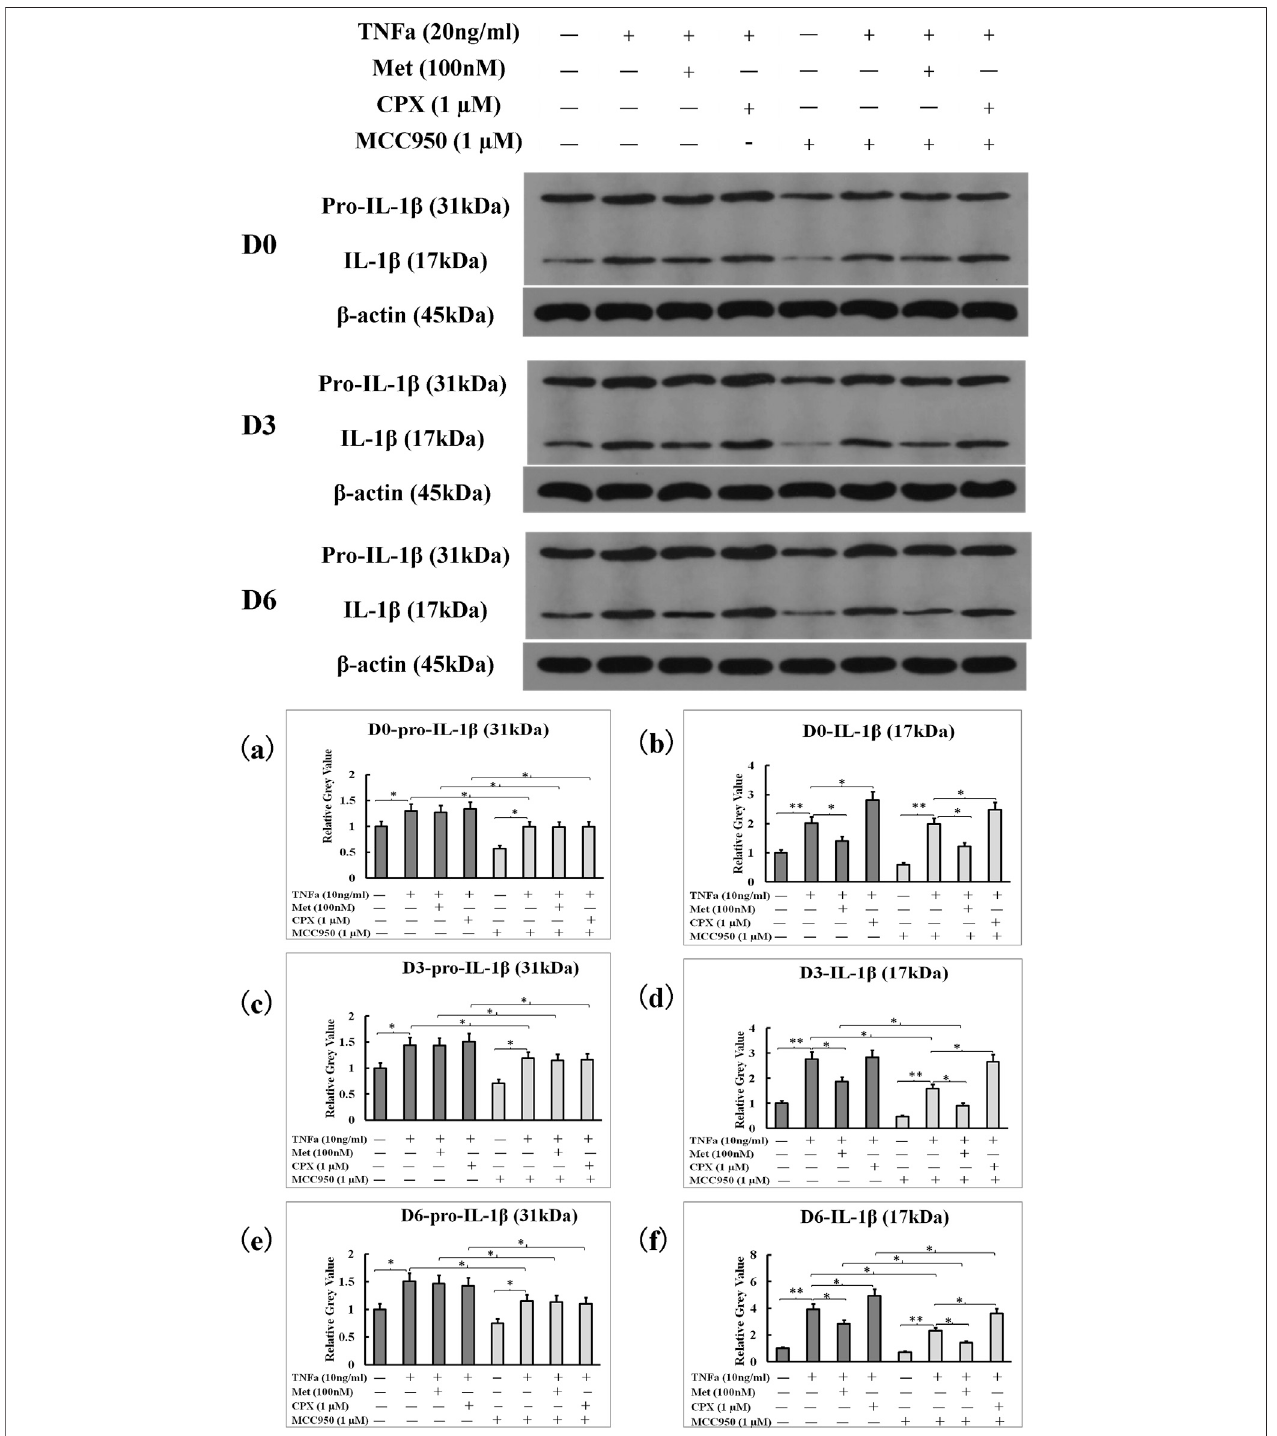
FIGURE 5 | NLRP3 inhibitor, MCC950, inhibited overall pro-IL-1 β and IL-1 β protein levels induced by TNF α . C2C12 cells were incubated in the presence of TNFa (20 ng/ml), TNFa + Met (100 nM) or TNFa + CPX (1 µM) or overall MCC950 (1 µM) for 12 h at D0, D3, or D6. The pro-IL-1 β (31 kDa) and mature IL-1 β protein (17 kDa) levelswereassessed bywesternblot.* p < 0.05,and** p < 0.01betweentwocomparedgroups. (A,B) :Thegrey-valuesofwesternblotonpro-IL-1 β andIL-1 β proteinsat D0 were calculated by normalized protein expressions to β -actin. (C,D) : The grey-values of westernblot on pro-IL-1 β and IL-1 β proteins at D3 were calculated by normalizedproteinexpressionsto β -actin. (E,F) :Thegrey-valuesofwesternblotonpro-IL-1 β andIL-1 β proteinsatD6werecalculatedbynormalizedproteinexpressions to β -actin. Ctrl, control; TNFa, murine Tumor Necrosis Factor-alpha; Met, methimepip; pro-IL-1 β , the precursor of interleukin 1beta; IL-1 β , interleukin 1beta; CPX, ciproxifan. D0, undifferentiated cells; D3, cells differentiated for 3 days; D6, cells differentiated for 6 days.